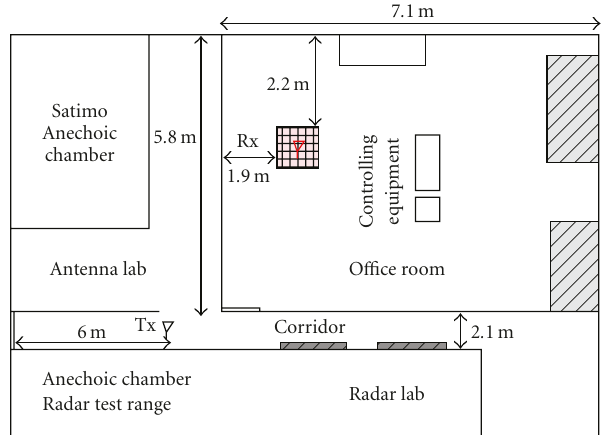
Figure 8: Environment layout of the first measurement